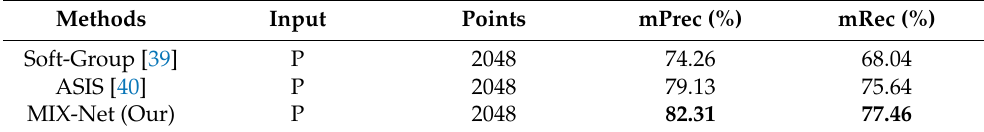
Table 3. Instance segmentation results of MIX-Net on seedling point cloud datasets.